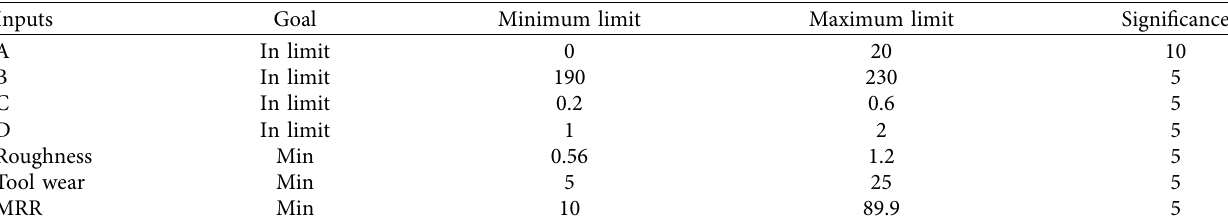
Figure 5: Mechanism of tool wear in AA 2618, AA 2618/ZrC composite, and AA2618/ZrC/RHA hybrid composite. Table 9: Optimization goal and input